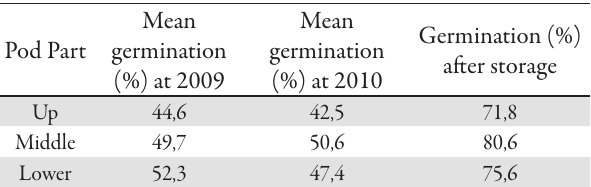
Tab. 5. Effect of different parts of pod on seed moisture in 2009 and